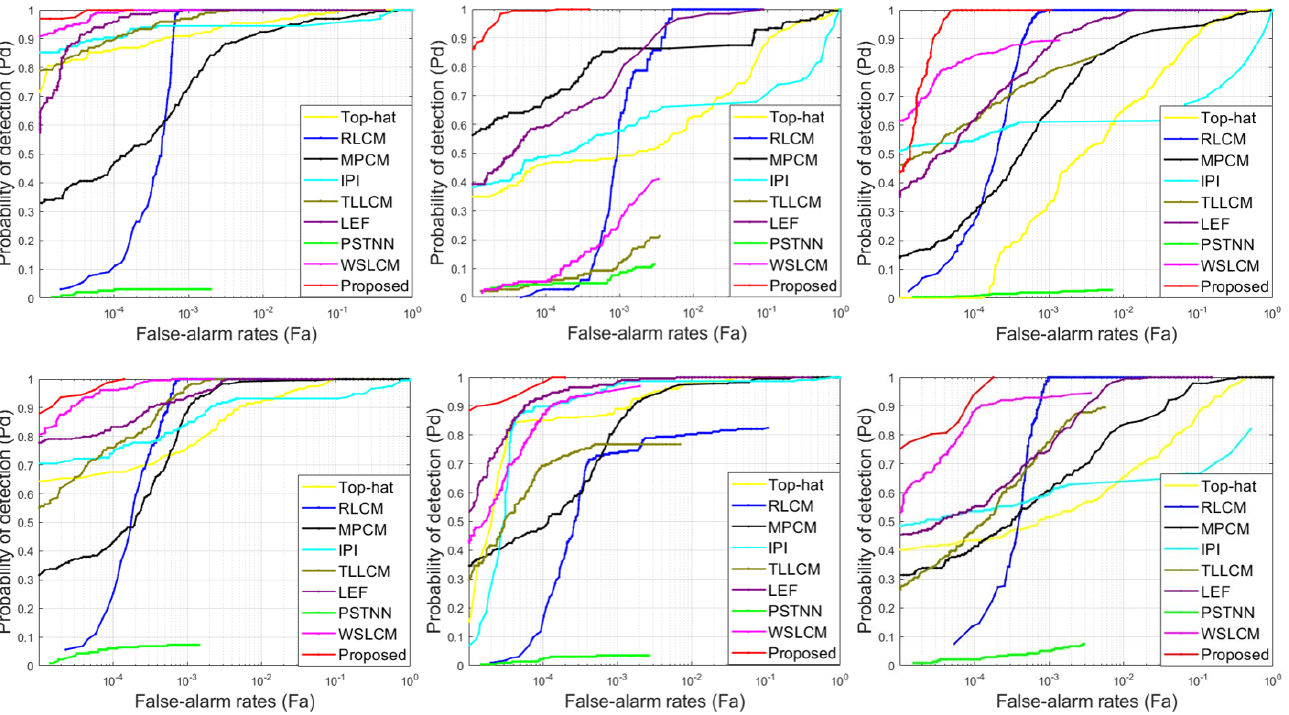
Figure 8. ROC curves of different methods in six real